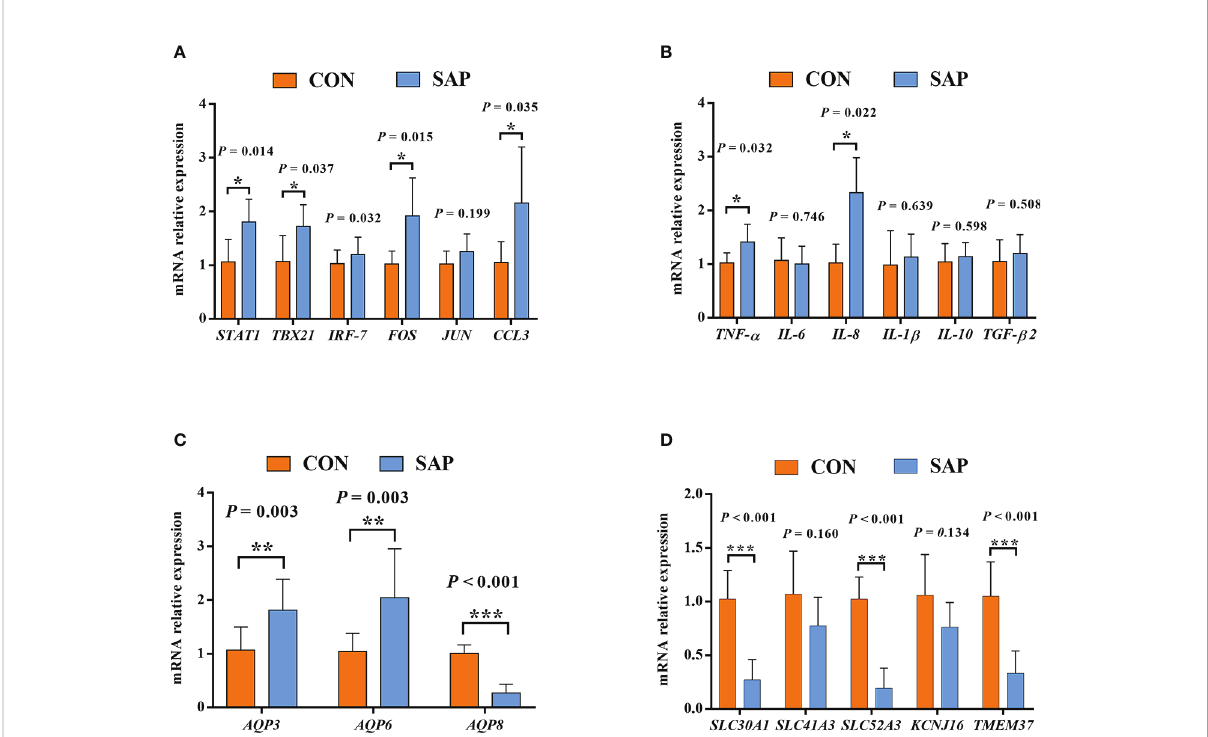
FIGURE 9 Effect of dietary soybean saponin Bb mRNA relative expression of large intestinal immune-related genes (A, B) and membrane transport/ channels (C, D) ( n = 6). * p < 0.05; ** p < 0.01; *** p < 0.001; Student ’ s t -test. STAT1 , signal transducer and activator of transcription 1; TBX21 , T- box transcription factor 21; IRF7 , interferon regulatory factor 7; FOS , Fos proto-oncogene (AP-1 transcription factor subunit); JUN , Jun proto- oncogene (AP-1 transcription factor subunit); CCL3 , C – C motif chemokine ligand 3; TNF- a , tumor necrosis factor alpha; IL-6 , interleukin 6; IL- 8 , interleukin 8; IL-1 b , interleukin 1 beta; IL-10 , interleukin 10; TGF- b 2 , transforming growth factor beta 2; AQP3 , aquaporin 3; AQP6 , aquaporin 6; AQP8 , aquaporin 8; SLC41A3 , solute carrier family 41 member 3; SLC30A1 , solute carrier family 30 member 1; SLC52A3 , solute carrier family 52 member 3; KCNJ16 , potassium inwardly rectifying channel subfamily J member 16; TMEM37 , transmembrane protein